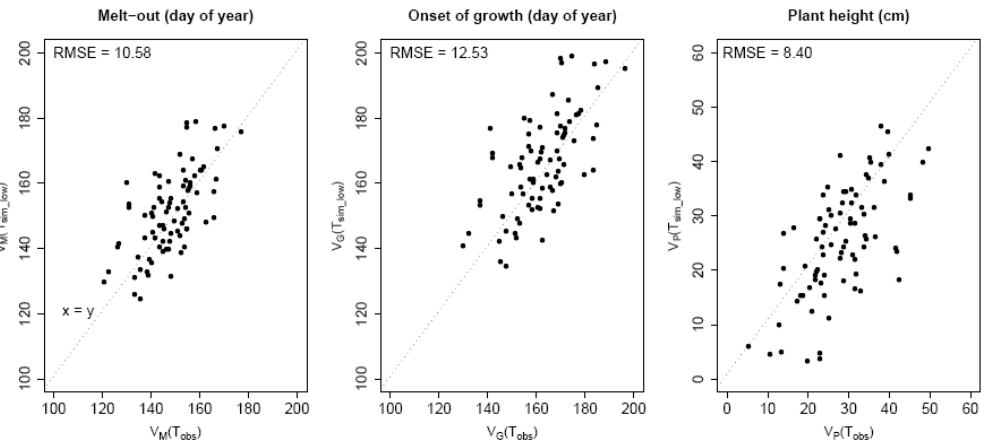
Figure 3 Fig. 3. Comparison of melt out, onset of growth and plant height as predicted from measured May/June-mean temperature ( T obs ) and the low resolution climate data ( T sim low ) for the current period